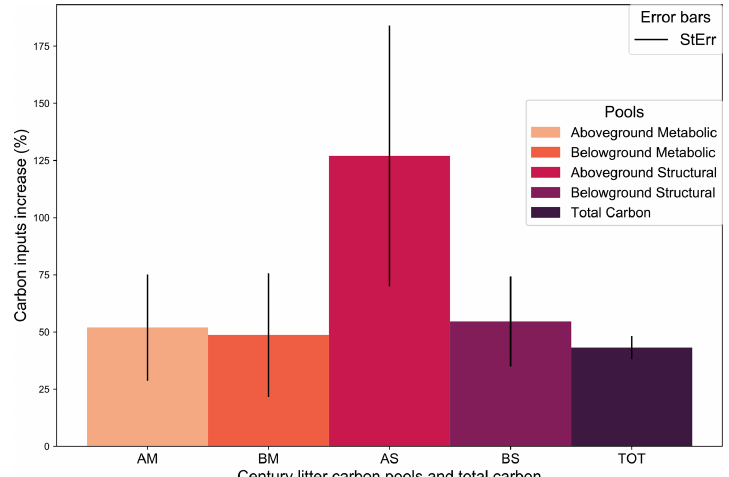
Figure 6. Site average percentage change of carbon inputs needed to reach the 4p1000 (TOT), separated into the four litter input pools. AM: aboveground metabolic; BM: belowground metabolic; AS: aboveground structural; BS: belowground structural; TOT: total litter inputs. Error bars indicate the standard error. N.B: total change of carbon inputs (TOT) was calculated as the percentage change between the total amount of carbon inputs before and after the 4p1000 optimization, averaged across all